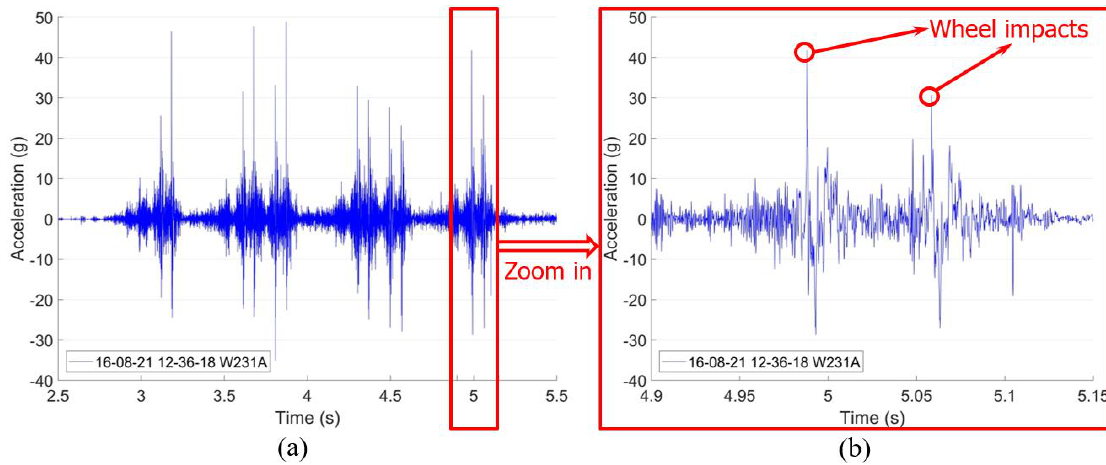
Figure 5. Measured crossing dynamic responses using the instrumentation: ( a ) vertical acceleration response of one train (12 wheelsets) and ( b ) examples used for wheel impacts extraction.